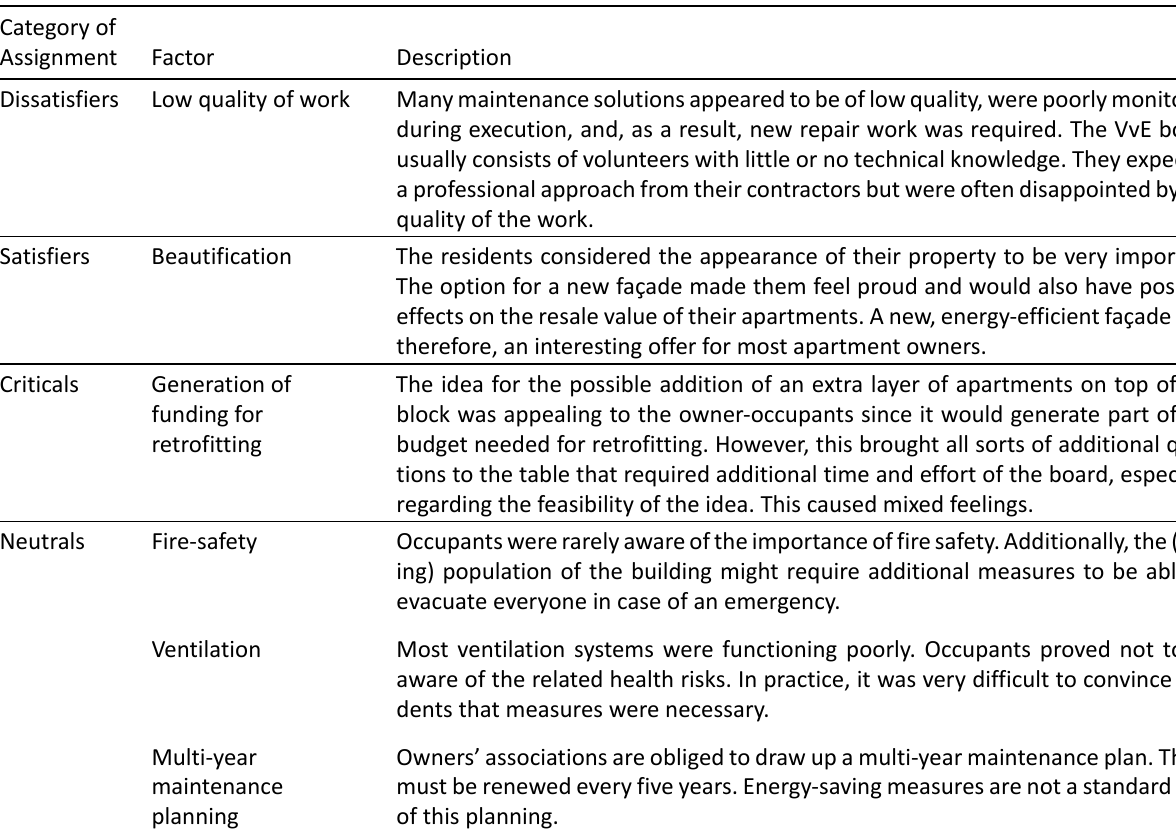
Table 4. Dissatisfiers, satisfiers, criticals, and neutrals in the perception of owner‐occupants involved in VvEs. Category